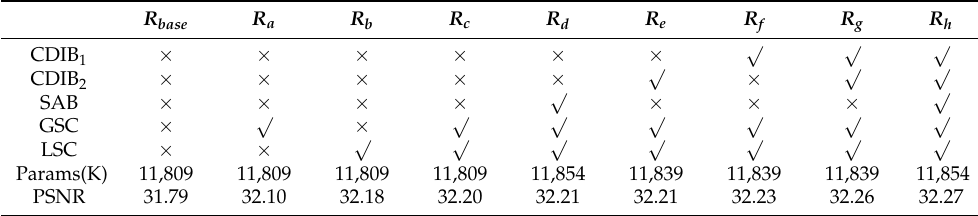
Table 2. The ablation results of the key components (i.e., CDIB 1 , CDIB 2 , SAB, GSC, and LSC). The best PSNR (dB) is tested on Set5 ( × 4) in 100